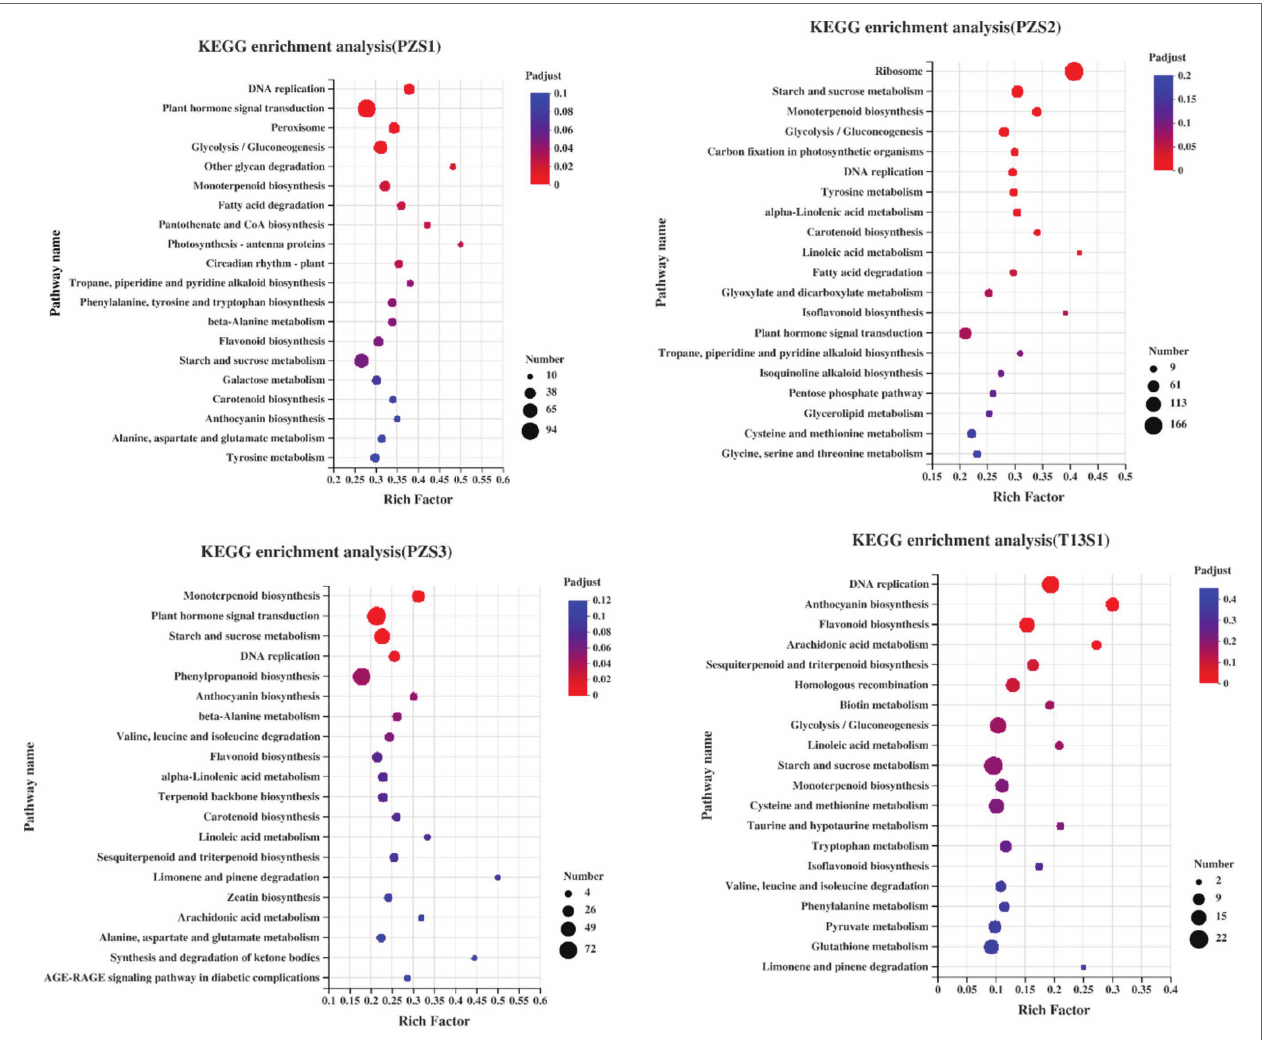
FIGURE 3 | Kyoto Encyclopedia of Genes and Genomes (KEGG) analysis of all DEGs in four pairwise groups: PZS1H vs. PZS1D (PZS1), PZS2H vs. PZS2D (PZS2), PZS3H vs. PZS3D (PZS3), and T13S1H vs. T13S1D (T13S1). The circle size represents the number of DEGs detected in the KEGG pathway. The rich factor is the ratio of DEGs to the total background gene number in each